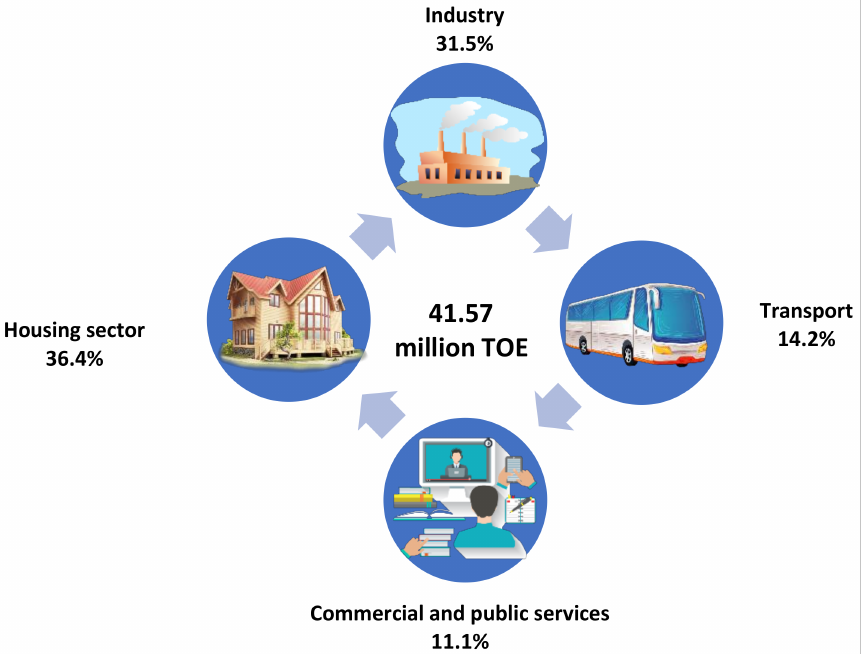
Figure 2. Structure of the main items of final consumption of fuel and energy resources in Kazakhstan in 2019, million TOE. Source: Compiled by the authors based on data from [69,70].